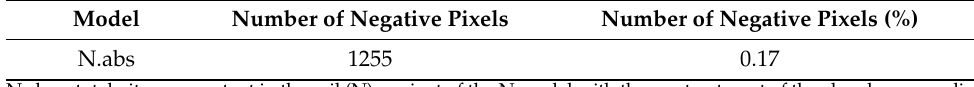
Table 1. Descriptive statistics for pixels with negative